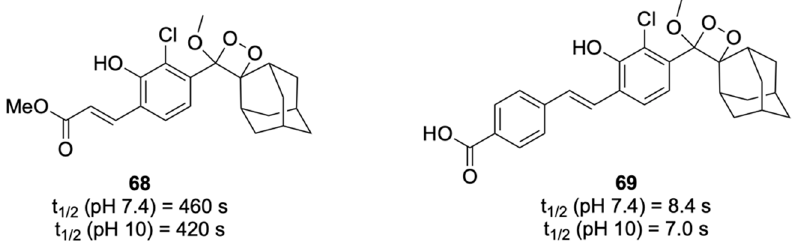
Figure 10. Structures of improved luminophores 68 and 69 [65].